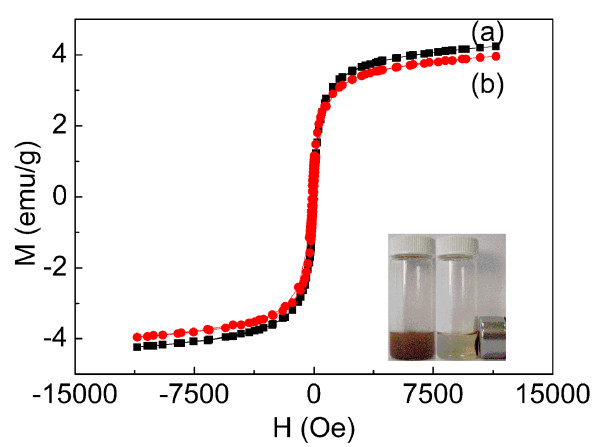
Magnetization curves of the Fe3O4@SiO2 (a) and DTH-Fe3O4@SiO2 (b). Inset shows that DTH-Fe3O4@SiO2 was dispersed to an external magnet in ethanol.